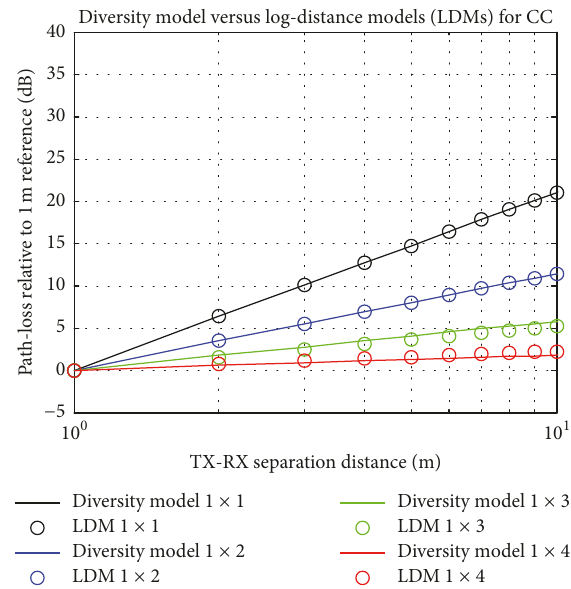
Figure 12: Path-loss for the proposed log-distance-based diversity model given by (5) for the CC scheme when considering LOS scenario, with 𝑛 SISO = 2.105 and 𝐴 = 0.458 .